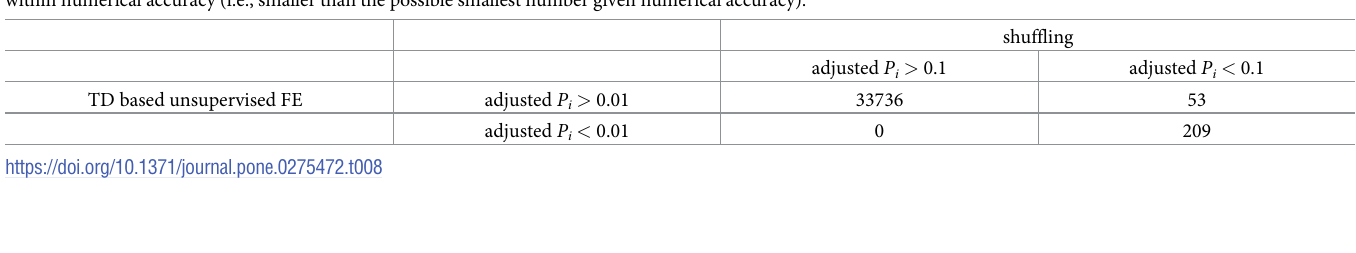
Table 8. Confusion matrix of selected mRNAs between TD-based unsupervised FE and shuffling in the second data set. P -value computed by Fisher’s exact test is 0.0 within numerical accuracy (i.e., smaller than the possible smallest number given numerical